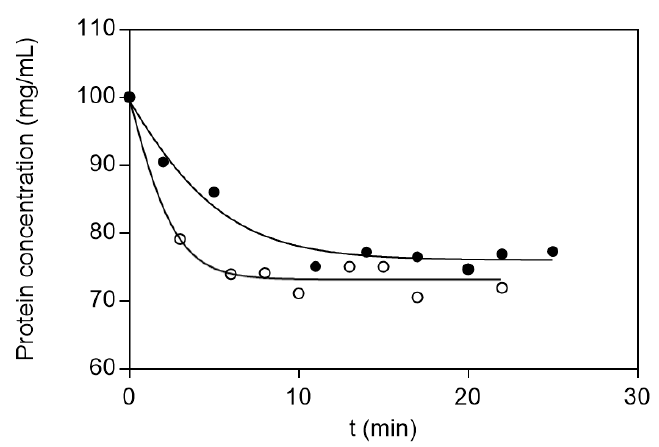
Figure 5. Equilibrium adsorption kinetics of LYS (white plots) and BSA (black plots) on CB3GA- Cellulose-2 adsorbent in batch system at 4 °C.